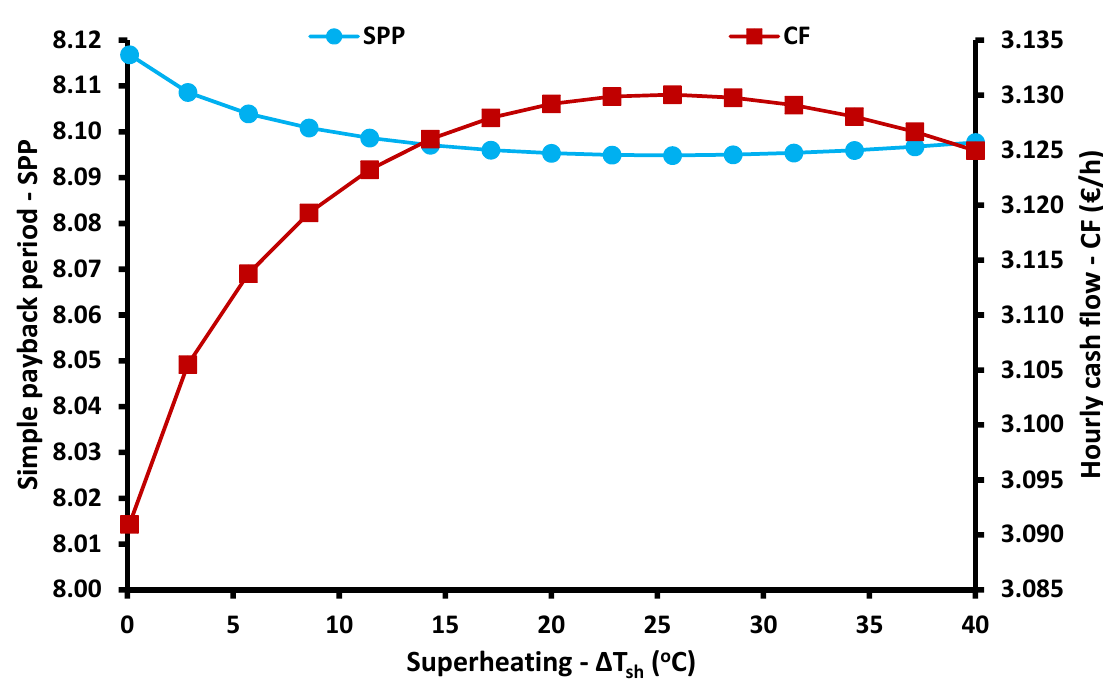
Figure 7. Simple payback period and hourly cash flow for different superheating levels.